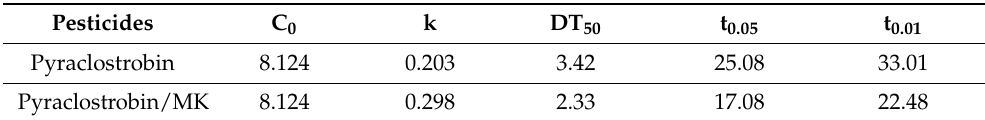
Figure 8. Boscalid disappearance dynamics curve in wastewater without microorganisms (PYR) and enriched with microorganisms (PYR/MIK) passed through a constructed wetland bed. Table 7. Values of the coefficients of the equations of the dynamics of disappearance of pyraclostrobin with and without the addition of microorganisms (MK), half-life times of pesticides in DT 50 wastewa- ter and theoretical times to reach concentrations of 0.05 and 0.01